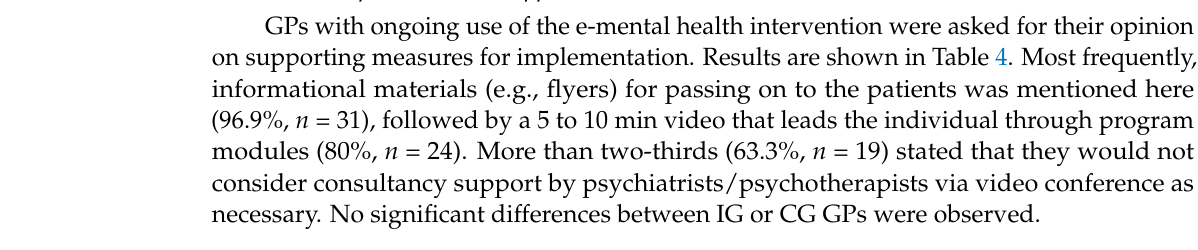
Table 4. Necessary implementation measures 1